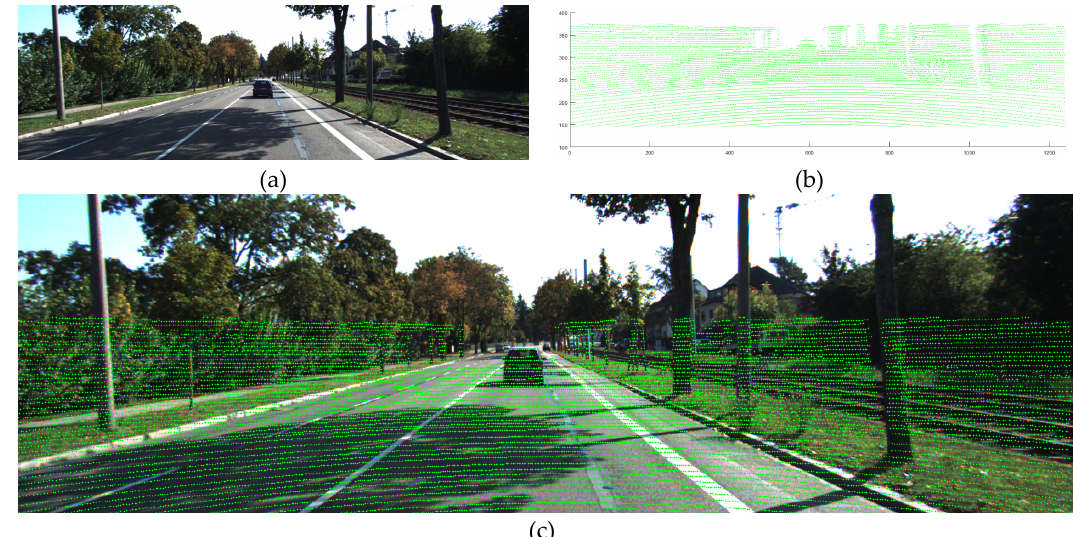
Figure 3. ( a ) Acquired image; ( b ) Acquired point cloud; ( c ) Point projection onto image through spatial registration.